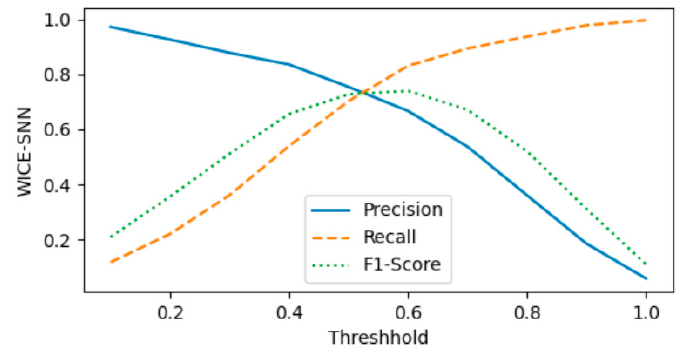
Figure 3. Performance Change with Parameter (Threshhold ∈ [0.1, 1]).